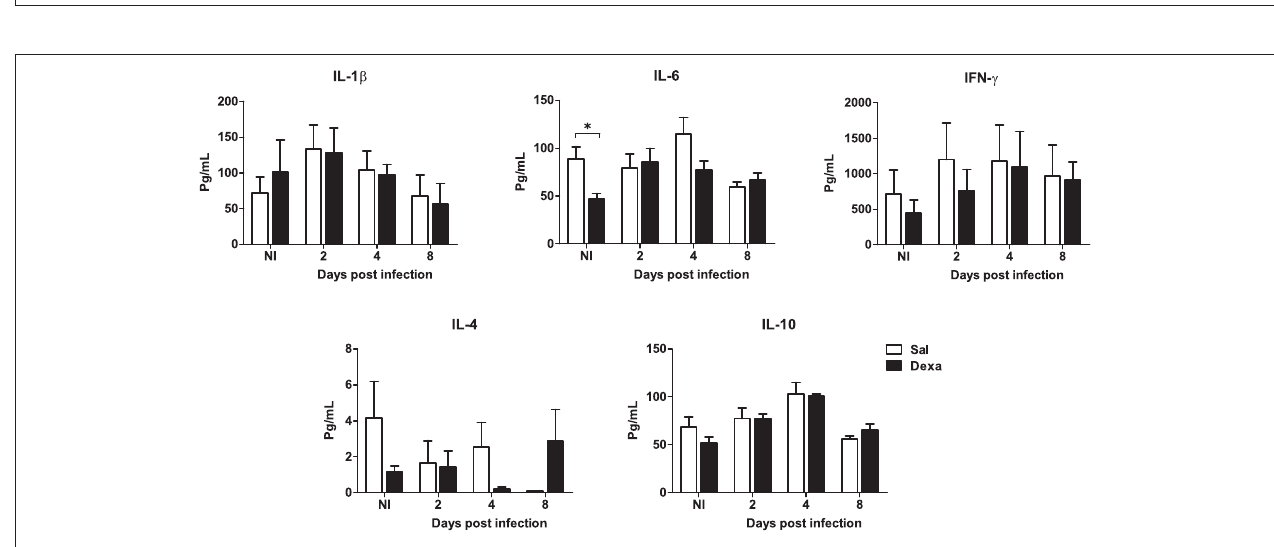
FIgure 7 | Adult rats prenatally treated with Dexa or with Sal present a similar serum cytokine profile after L. monocytogenes . IL-1 β , IL-6, IFN- γ , IL-4, and IL-10 production upon infection was determined measuring their serum concentration with a multiplex cytokine assay. Each point represents one rat and the line corresponds to the mean of six to eight rats per group.